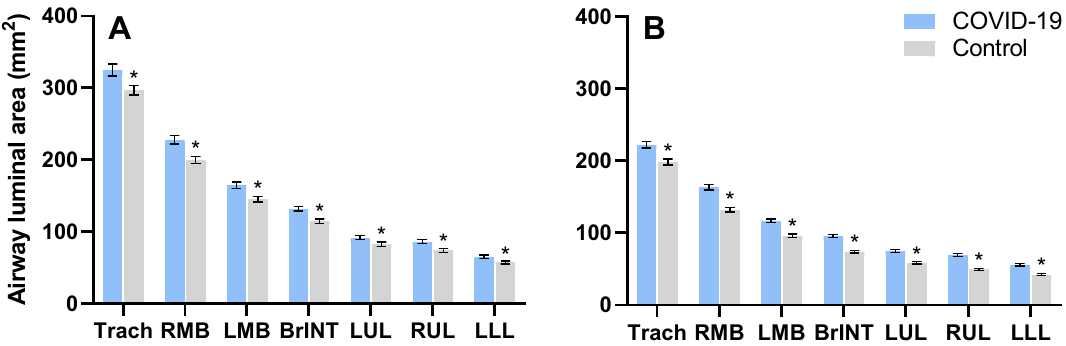
Figure 2. The luminal area of the conducting airways in the height-matched males ( A ) and females ( B ). Data are presented as mean ± SE. Trach, Trachea; RMB, right main bronchus; RUL; right upper lobe; BrINT; bronchus intermediate; LMB, left main bronchus; LUL, left upper lobe; LLL, left lower lobe.